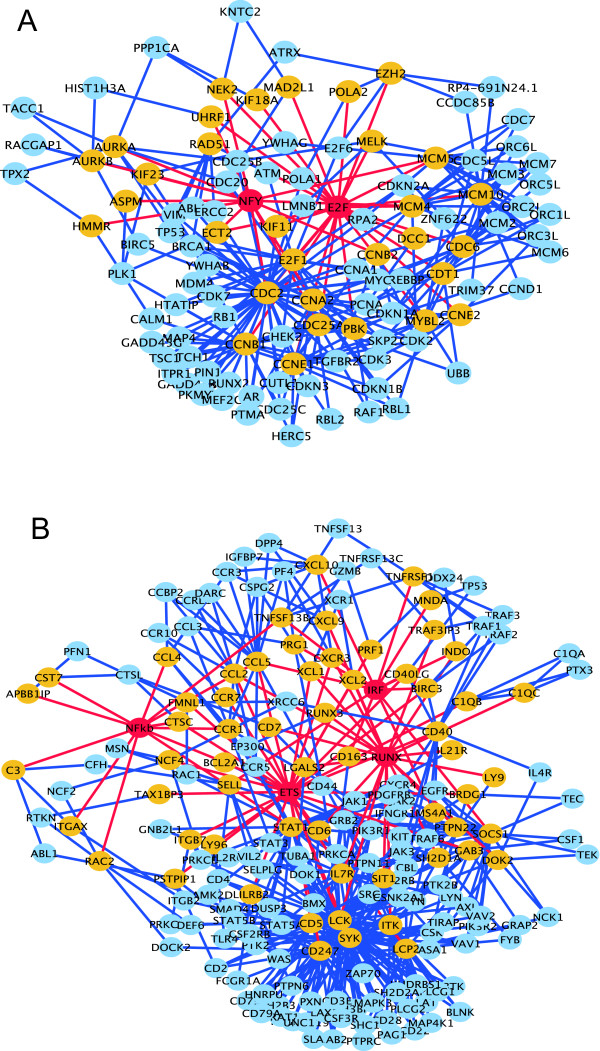
PPI and transcriptional sub-networks in breast tumors. (A) The E2F and NFY expression modules and an overlapping PPI sub-network. (B) The ETS, IRF, NFκB, and Runx expression modules and an overlapping PPI sub-network. For clarity, we displayed nodes which have more than one links. Red, yellow and blue nodes denote transcriptional regulators, regulated genes, and their interacting partners, respectively. Red links denote transcriptional regulations predicted by our analysis, and blue links denote PPIs registered in the HPRD.